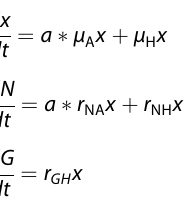
F N : Nitrate demand every 8 h ð mg = L Þ F G : Glucose demand every 8 h ð mg = L Þ The peristaltic pumps will pump nitrate and glucose into the bioreactor ( T pump,N , T pump,G ) based on nitrate and glucose demand on a per liter basis ( F N , F G (mg/L)), feed stock concentration ( C N , C G (mg/mL)), volume of the bioreactor ( V ( L )) and pump volumetric fl ow rate speed ( Q (mL/s)). ð Þ (cid:3) V ð L Þ ð Þ (cid:3) 2 ð L Þ mg ¼ F N mg L T pump ; N ¼ F N L C N mg mL ð Þ (cid:3) Q mL s ð Þ 5 mg mL ð Þ (cid:3) 3 mL s ð Þ